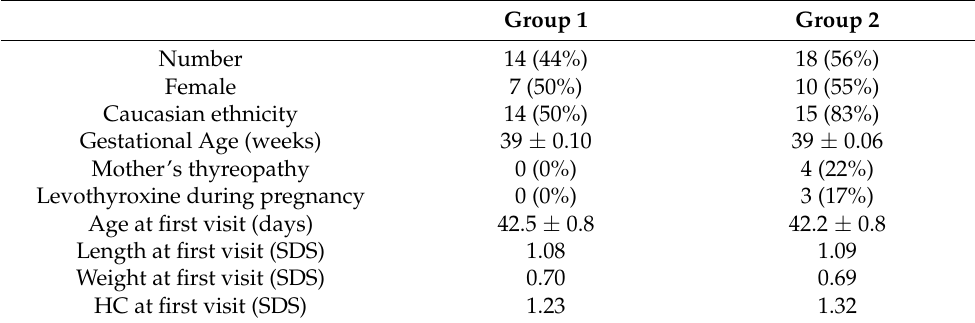
Table 1. Clinical characteristics of treated (Group 1) and untreated (Group 2)